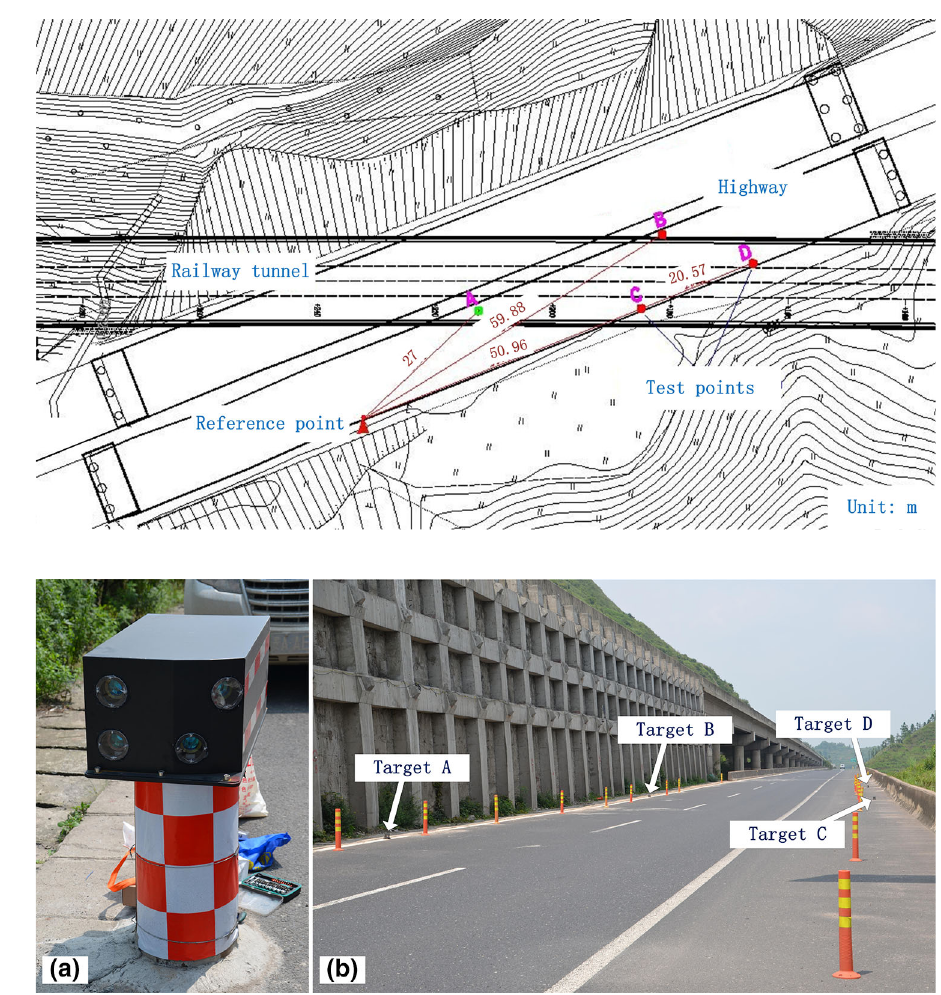
Fig. 4 Photograph of the remote monitoring system, including ( a) the detection device at the reference point and ( b) the four LED targets at the test